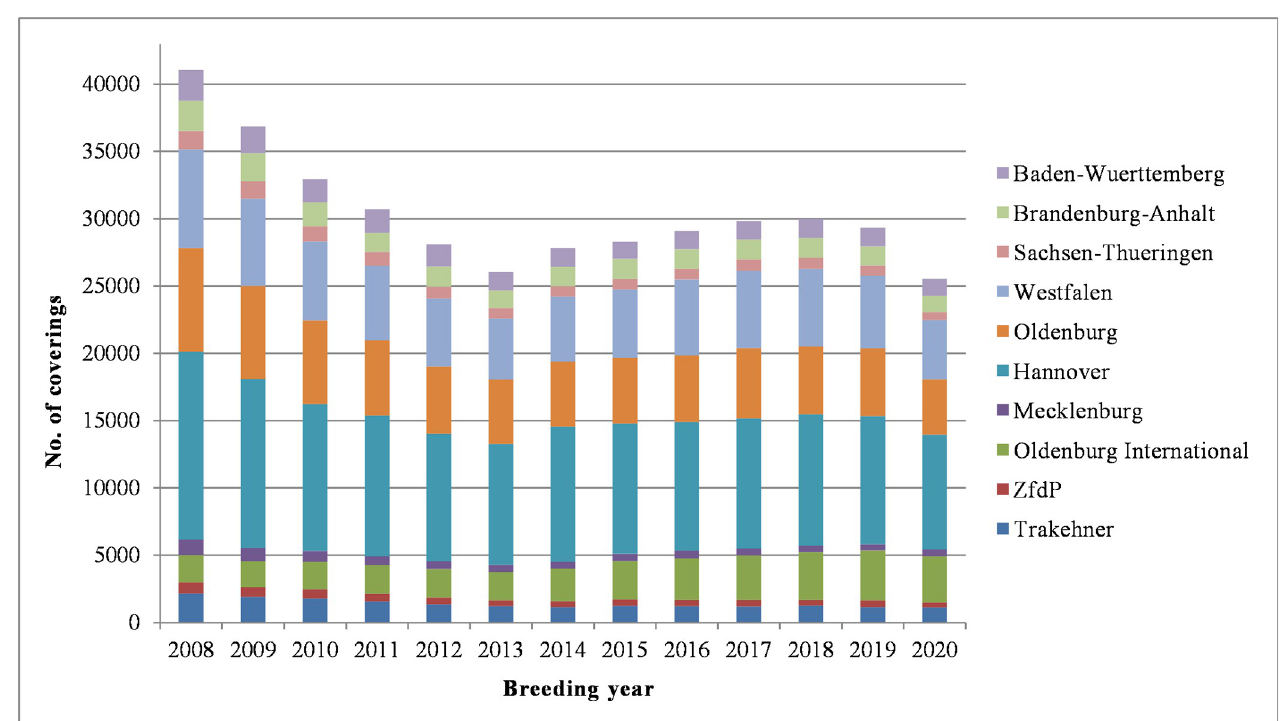
Fig 1. Distribution of effective coverings by year and breeding association. Covering data from ten German studbooks of riding horses in the study period from 2008 to 2020 were available, and last covering records of mares per breeding season (effective coverings) were used for analyses.